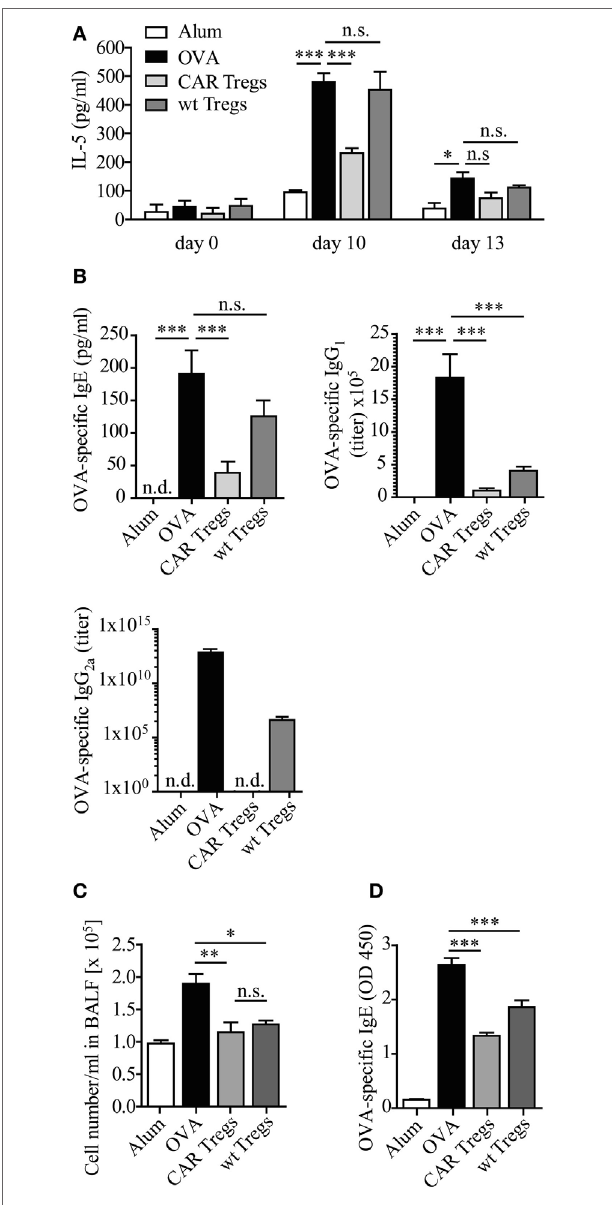
FigUre 5 | IL - 5 and allergen-specific IgE levels are diminished upon chimeric antigen receptor (CAR) regulatory T cell (Treg) treatment of carcinoembryonic antigen transgenic (CEAtg) mice. (a) IL-5 levels in sera from CEAtg mice were determined at different times of the experimental protocol ( Figure 3a ), n = 3 mice per group per time point; statistical analysis was performed using the two-way ANOVA test. (B) The amount of ovalbumin (OVA)-specific IgE ( n = 6–8 mice), IgG 1 ( n = 6–9), and IgG 2a ( n = 6–17) in sera of CEAtg mice. Data are pooled from two to three independent experiments. (c) Total number of bronchoalveolar lavage fluid (BALF) cells in wild-type (wt) C57BL/6 mice without CEA expression, treated as described in Section “Materials and Methods.” (D) OVA-specific IgE at day 12 in sera of C57BL/6 mice was recorded by ELISA. Statistical analysis was performed by the one-way ANOVA test, * p < 0.05, ** p < 0.01, *** p <